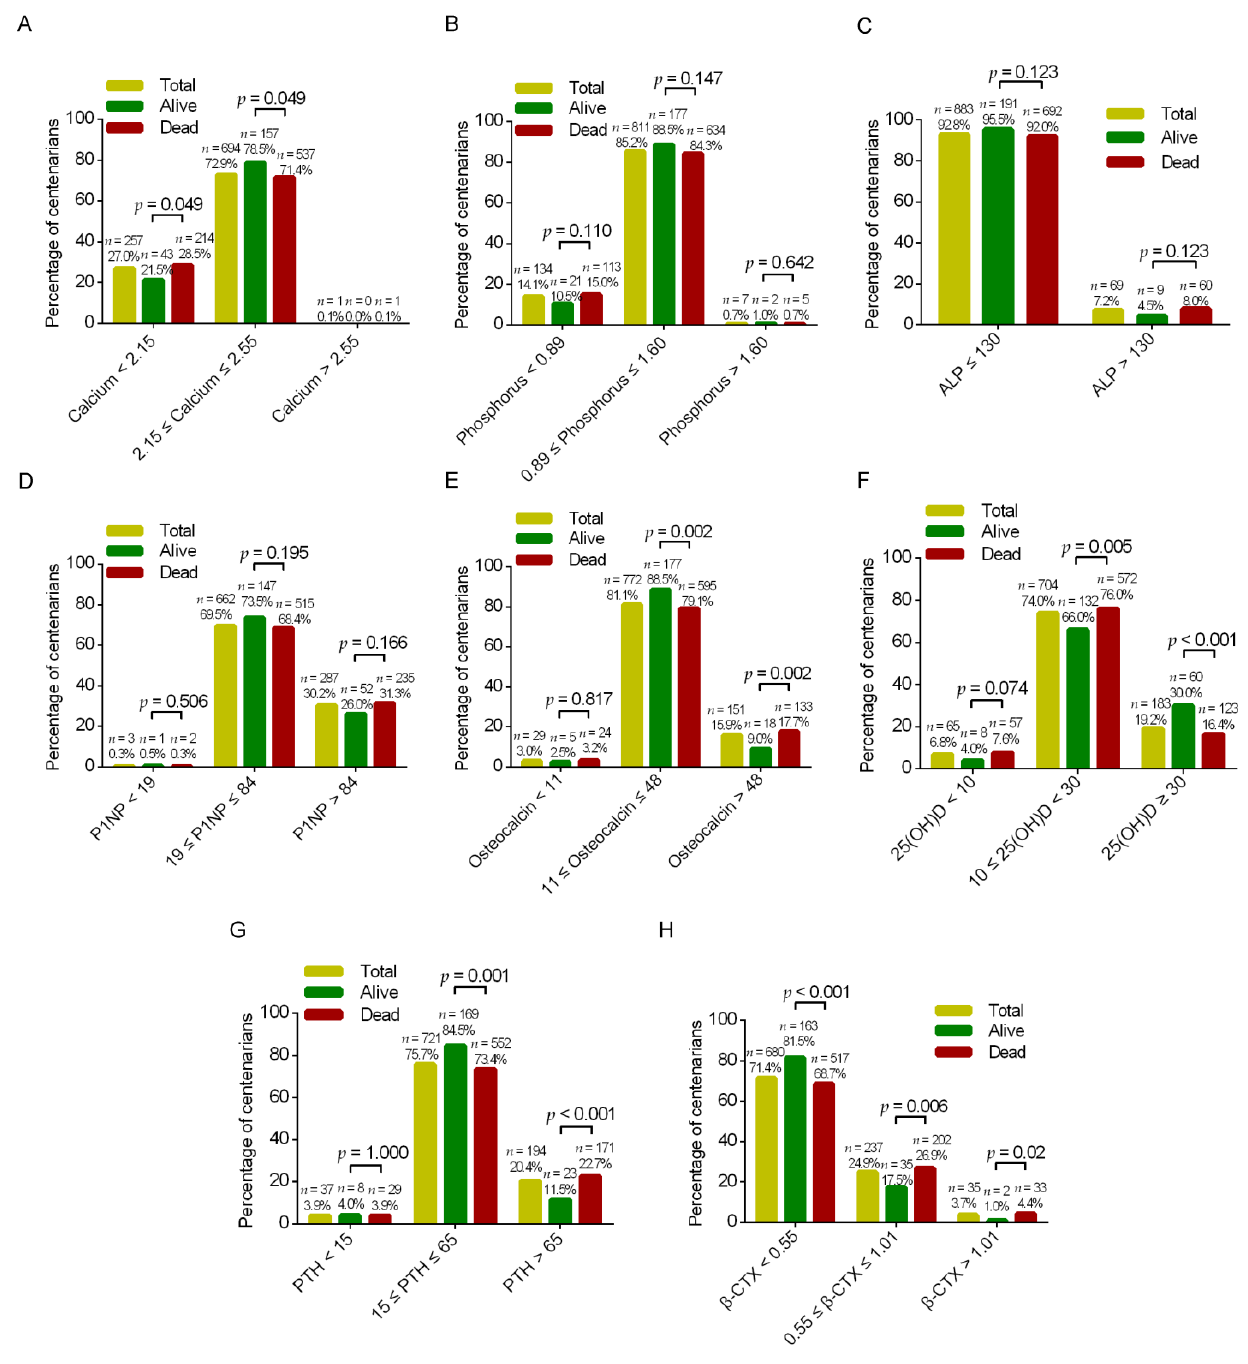
Figure 1. Distributions of centenarians according to serum calcium (mmol/L) ( A ), phosphorus (mmol/L) ( B ), ALP (U/L) ( C ), P1NP (μg/L) ( D ), osteocalcin (ng/mL) ( E ), 25(OH)D (ng/mL) ( F ), PTH (pg/mL) ( G ), and β-CTX (ng/mL) ( H ) (grouped by clinical reference values). 25(OH)D, 25-hydroxyvitamin D; ALP, alkaline phosphatase; β -CTX, β - C -terminal telopeptide of type 1 collagen; P1NP, procollagen type 1 N - terminal propeptide; PTH, parathyroid hormone. During a median follow-up of 32 months (IQR, 15, 55), nearly four-fifths of partici- pants died. The estimated 1-year, 3-year, and 5-year survival rates were 80.0%, 45.7%, and